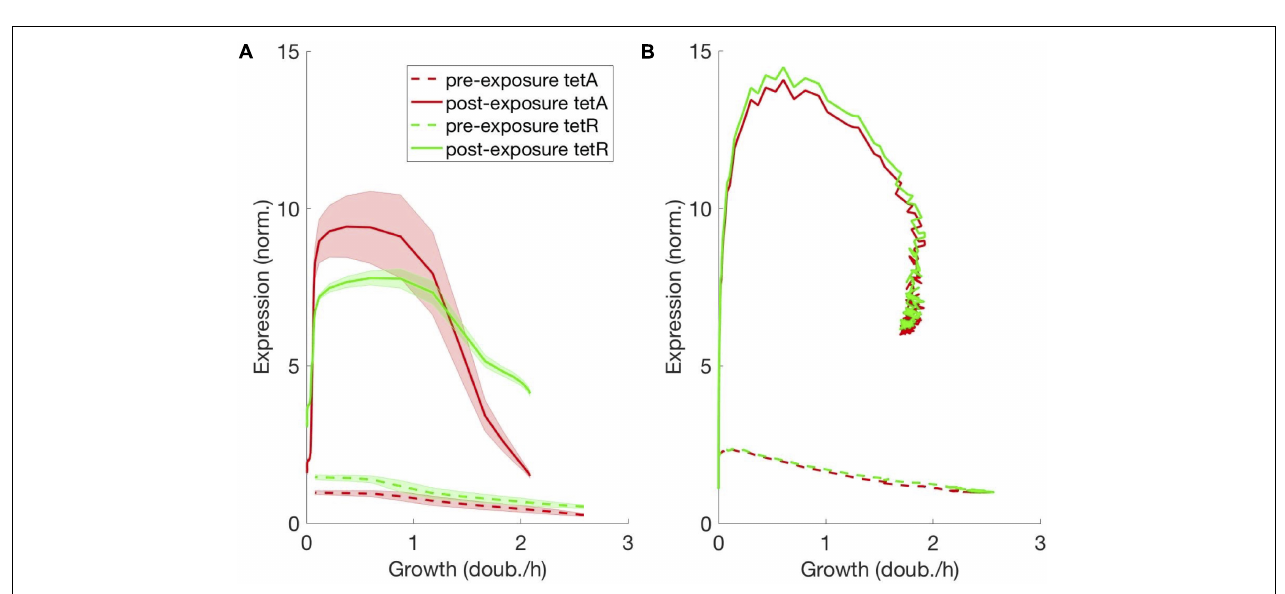
FIGURE 6 | Steady-state expression of resistance decreases linearly with cell growth. Functional relationship between expression of TetA/TetR and cell growth, obtained from the steady states with and without drug, both (A) measured in the trap and (B) simulated from the mathematical model. TetA and TetR expression decrease linearly with the cell growth rate, as predicted by the theory of proteome partition. At extremely low cell growth, both TetA and TetR expression remain low even in the presence of